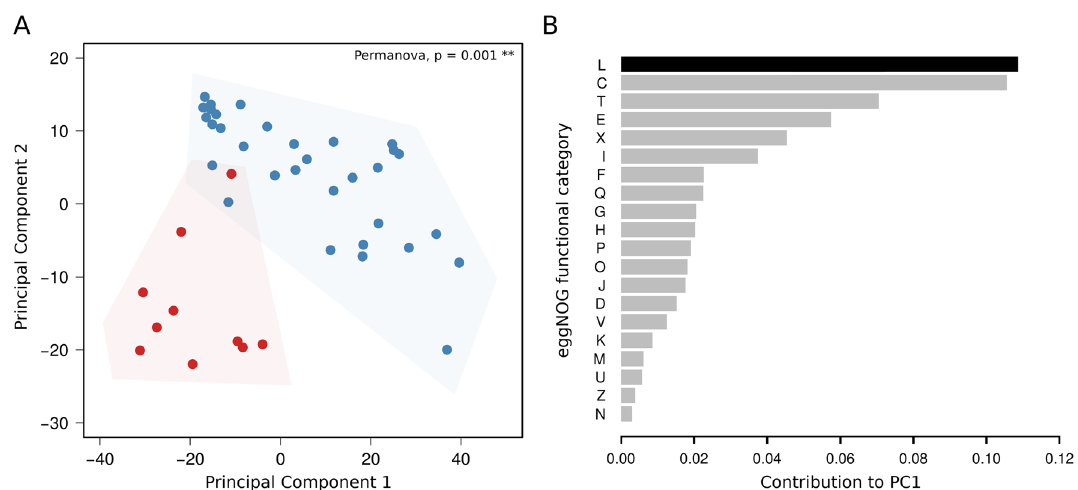
Figure 3. Functionally distinct accessory genomes in C. hyointestinalis subspecies. (A) Principal component analysis showing that C. hyointestinalis subspecies form two different clusters (p = 0.001, Permanova test) based on the functional analysis of their accessory genes. (B) Boxplot showing the contribution of each functional category to the variance explained by the first principal component (PC1). Functional category codes resemble those used by the eggNOG database. The top-ranking category (L: recombination and DNA repair) is highlighted in